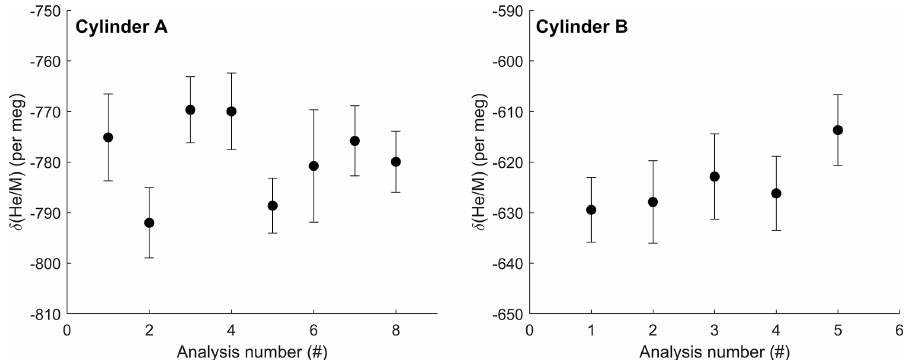
Figure 6. Repeat δ (He / M) analysis of two high-pressure cylinders against ambient La Jolla air collected in 2019. Each data point shown is the average of at least 300 individual 12s measurements with 1 σ error bars representing the standard error of each measurement. Repeat analyses show a standard deviation of 8.1 and 6.3 per meg (1 σ ) for cylinder A and cylinder B respectively. Analysis 6 for cylinder A was shorter, resulting in a larger uncertainty for that measurement. Data are not corrected for zero enrichment effects discussed in the text.